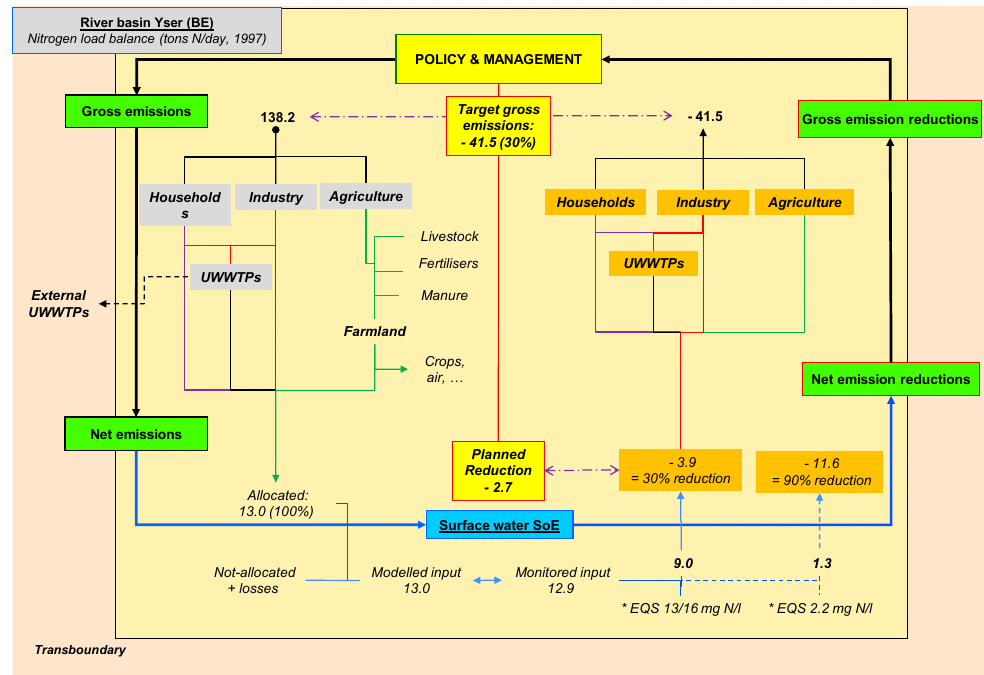
Figure 8. Nitrogen load balance of the Belgian Yser river basin. Gross and net emissions are calculated for different pollution sources (households, industry, agriculture, and urban wastewater treatment plants) and compared with the surface water pollution load. Required reductions according to the EQS values are calculated at the surface water (net emission reduction) and pollution source (gross emission reduction) levels. Comparison with the reduction effort calculated for a mix of measures (planned reduction) reveals that these measures are not sufficient to meet the least stringent environmental objectives. Figures are generated using several databases, algorithms, and models, applying estimations and other approaches to reduce uncertainty and data gaps. EQS 13/16 mg N/L is applied to protected drinking water areas and areas where basic quality standards apply; EQS 2.2 mg N/L equals a eutrophication level. (Data obtained from Muylle and Vannevel [40]).